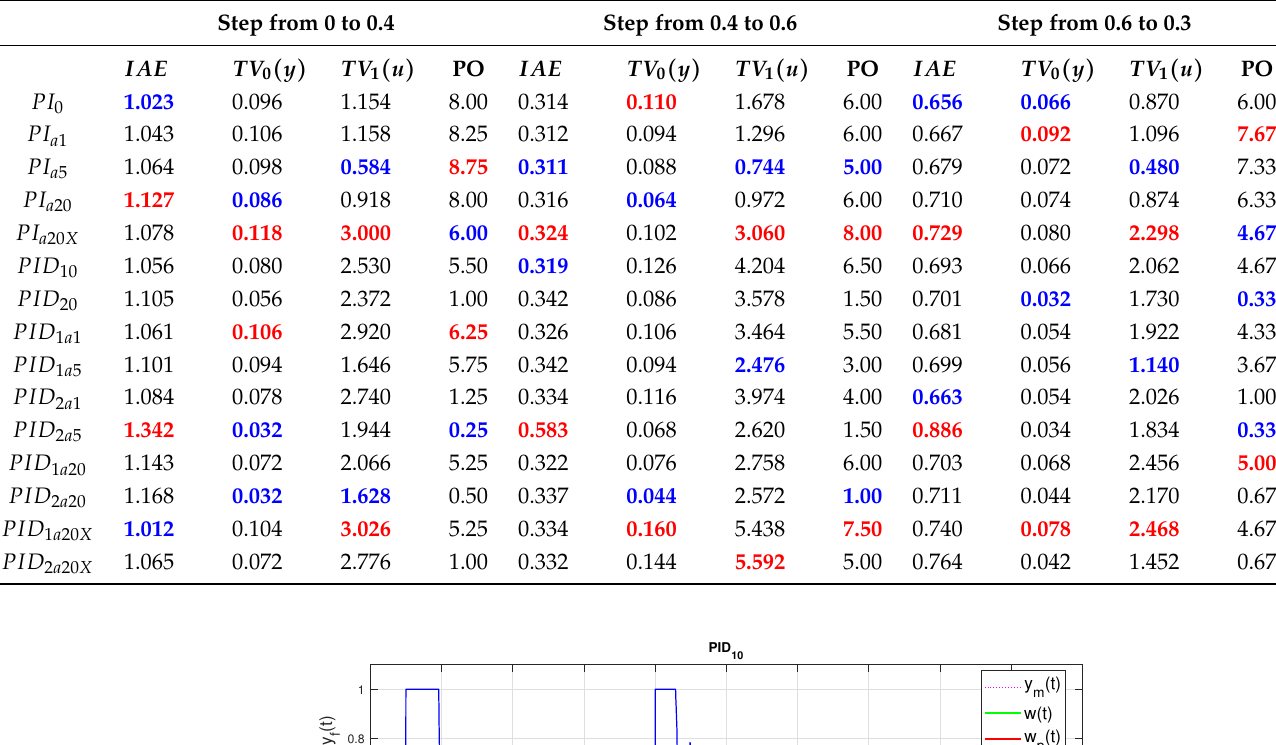
Table 1. Performance measures IAE , TV 0 ( y ) and TV 1 ( u ) corresponding to three steps for all experiments; PO—percentage overshoot; minimum—blue; maximum—red. Step from 0 to 0.4 Step from 0.4 to 0.6